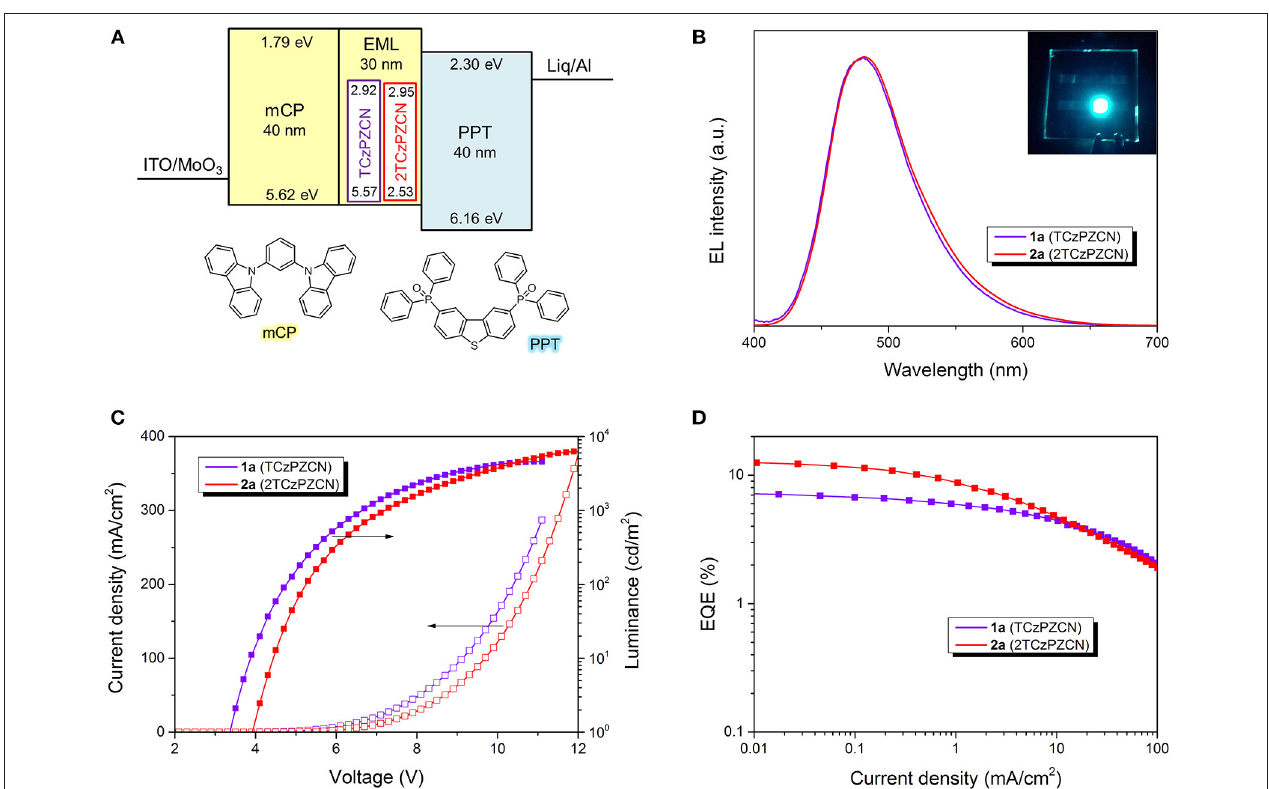
FIGURE 4 | Structures and performance of the thermally activated delayed fluorescence (TADF) organic light-emitting diodes (OLEDs). (A) Energy diagram of OLEDs. HOMO and LUMO levels of all compounds were measured by cyclic voltammetry. (B) Electroluminescence spectra at 1 mA/cm 2 . Inset: The image of Device 1a . (C) Luminance–current density–voltage characteristics of Devices 1a and 2a . (D) EQE–current density characteristics of Devices 1a and 2a .